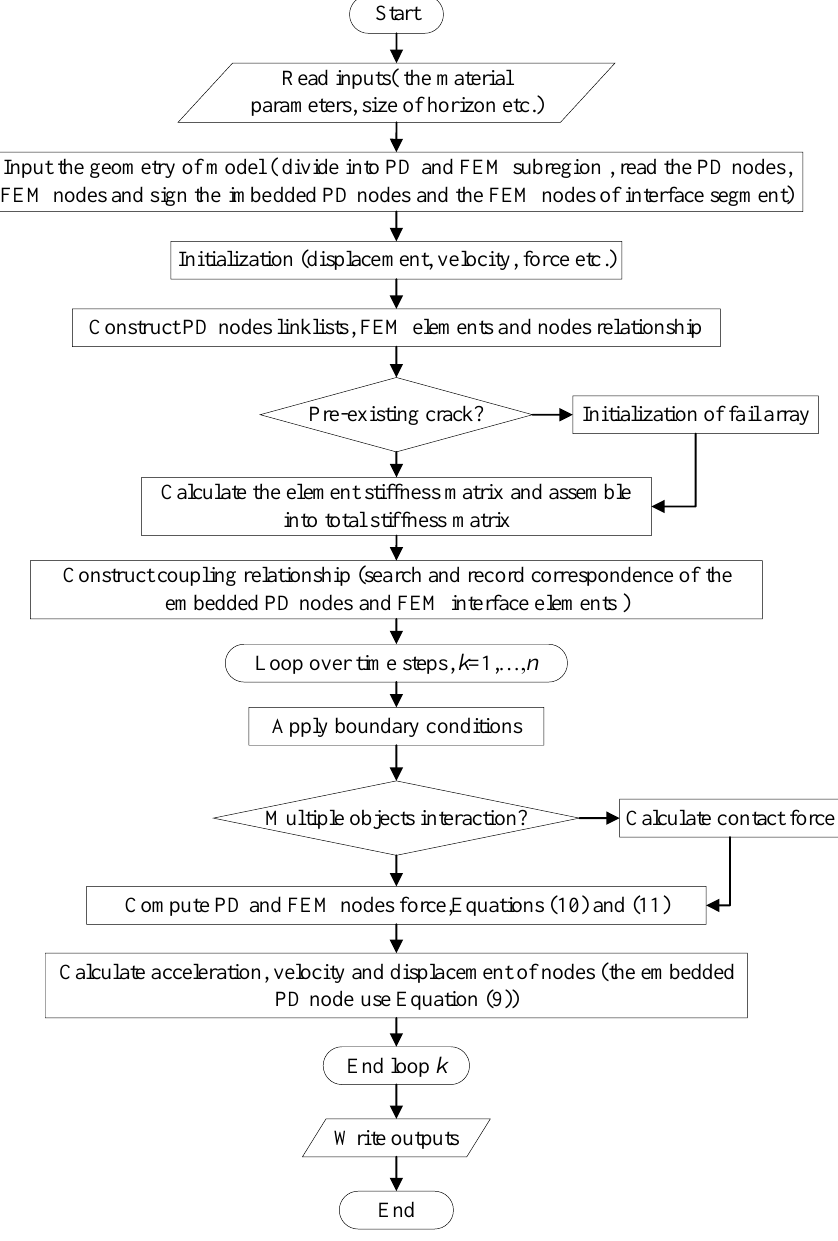
Figure 3. Flow chart of the FEM-PD coupling